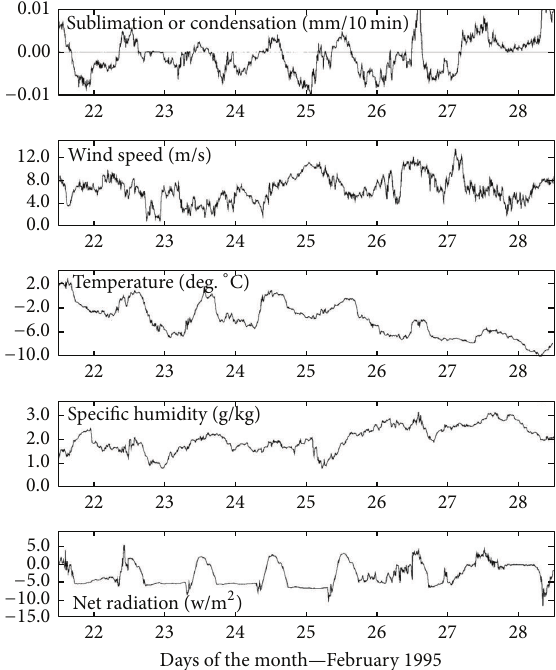
Figure 2: Reproduced from Hood et al. [14], ten-minute averages of sublimation, wind speed, temperature, specific humidity, and net radiation from Niwot Ridge, Colorado, USA. Tick marks denote the beginning of the day.